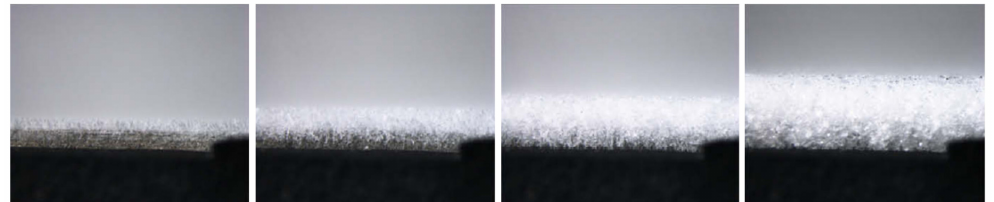
Figure 9. Schematic of the growth and densification of a frosted medium.